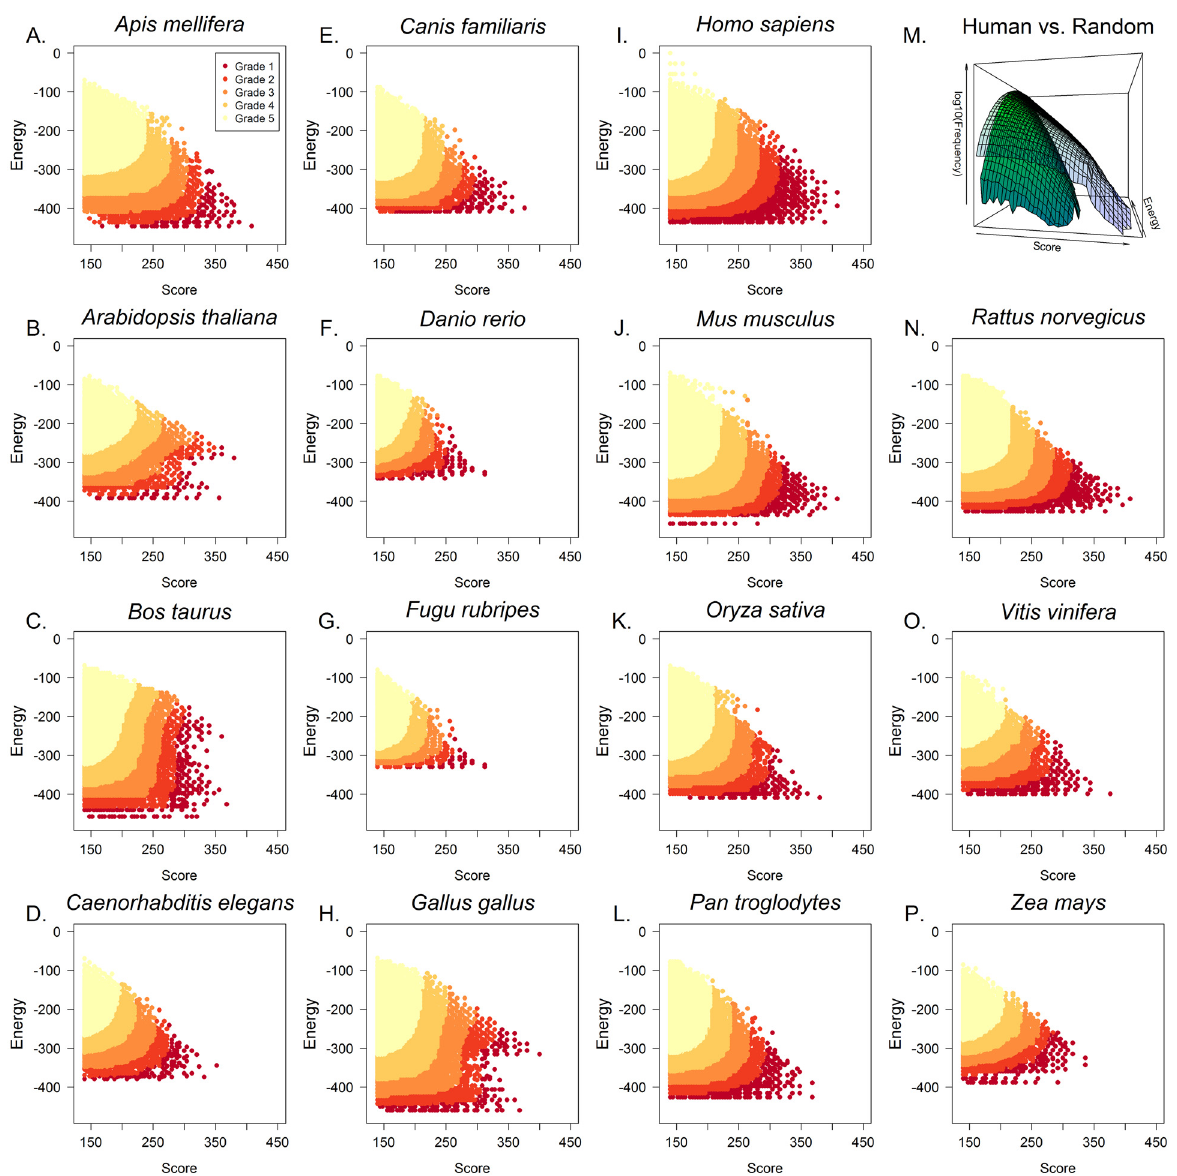
Fig 1. Triplex target sites are enriched in mammalian and non-mammalian genomes. (A-P) Genome-wide analyses of potential microRNA binding sites in genomic DNA were performed across fifteen species. The heuristic score ( ” Score ” , x-axis) represents Hoogsteen or Reverse Hoogsteen base pair complementarity and Thermodynamic Energy ( ” Energy ” , y-axis) represents the binding energy of the triplex (see Methods). Binding sites were categorized based on the number of hits with better score and energy. Grade 1 hits represent the 99.999 th percentile of triplex forming interactions, which are sequences most likely to participate in DNA-microRNA triplex formation. Subsequent grades are 10 fold lower in their percentile ranking (e.g. 99.99, 99.9, 99th percentiles). Additionally, randomly generated DNA sequences were analyzed against human microRNAs. The random DNA sequences (M, green surface) showed many orders of magnitude fewer binding sites than the human genome (M, blue surface) and the identified binding sites were of low quality (low score, high